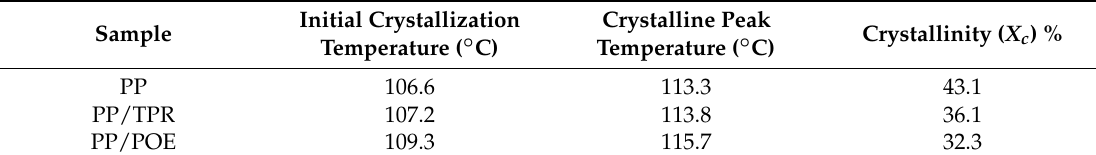
Figure 4. Crystallization curves of the PP composites. Table 2. Crystallization data of the PP composites.